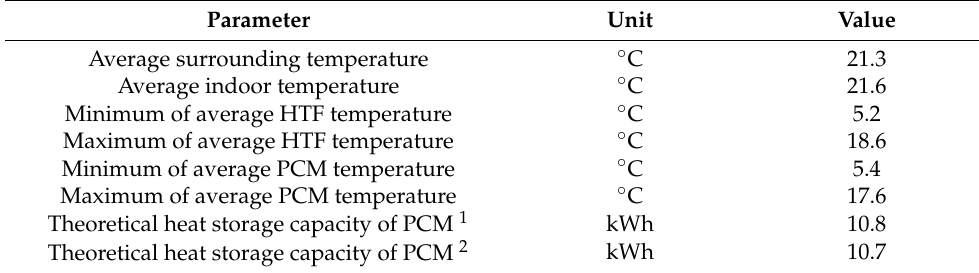
Table 8. Summary of important results obtained during the third cycle (24 h) of the experiment. Parameter Unit Value Average surrounding temperature ◦ C 21.3 Average indoor temperature ◦ C 21.6 Minimum of average HTF temperature ◦ C 5.2 Maximum of average HTF temperature ◦ C 18.6 Minimum of average PCM temperature ◦ C 5.4 Maximum of average PCM temperature ◦ C Theoretical heat storage capacity of PCM 1 Theoretical heat storage capacity of PCM 2